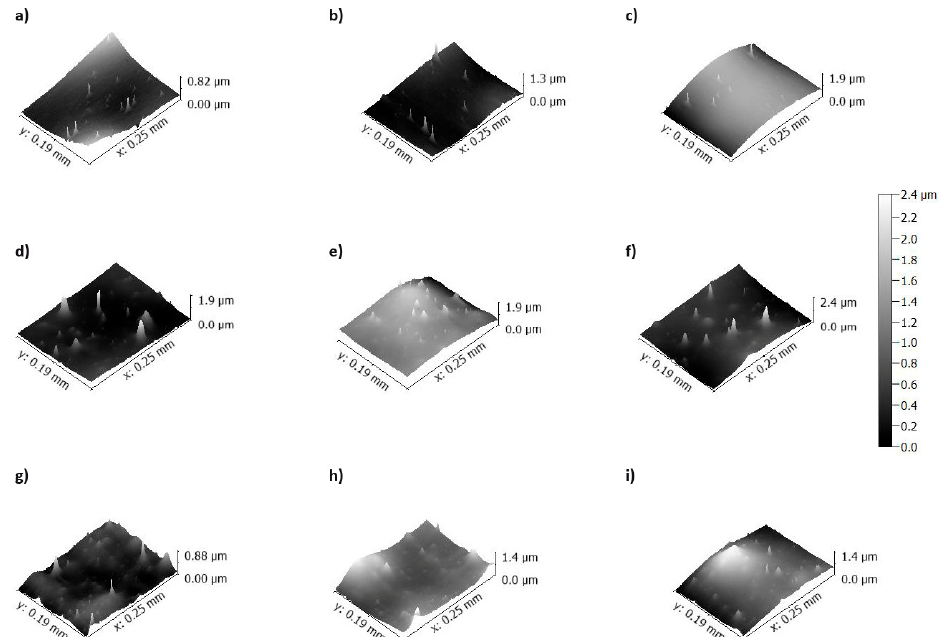
Figure 4. Surface topology of PLA films: ( a ) NTSS before plasma activation, ( b ) NTSS after oxygen plasma activation, ( c ) NTSS after argon plasma activation, ( d ) BCP before plasma activation, ( e ) BCP after oxygen plasma activation, ( f ) BCP after argon plasma activation, ( g ) TCL before plasma activation, ( h ) TCL after oxygen plasma activation, ( i ) TCL after argon plasma activation.